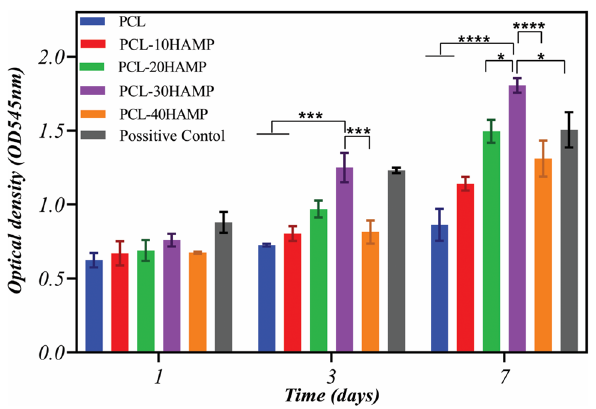
Figure 13. MTT results of the ARPE cells cultured on the tissue culture plate (as control) and electrospun scaffolds after 1, 3, and 7 days of cell